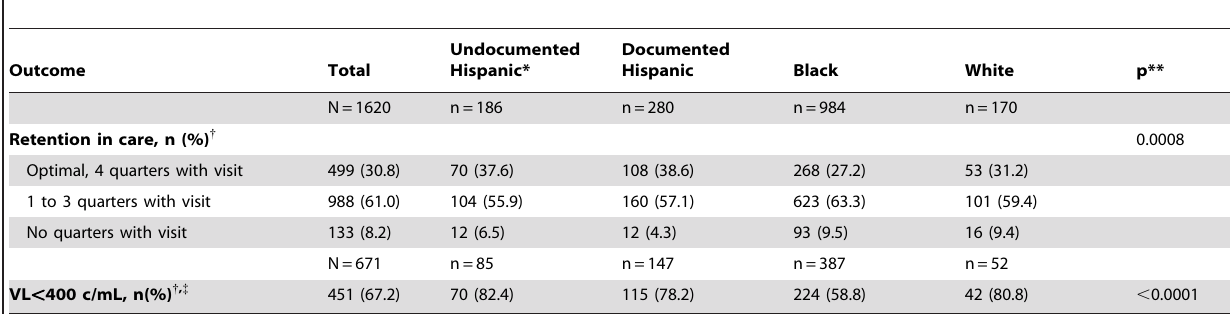
Table 2. Treatment outcomes one year after initiating care at Thomas Street Health Center in Houston, Texas.